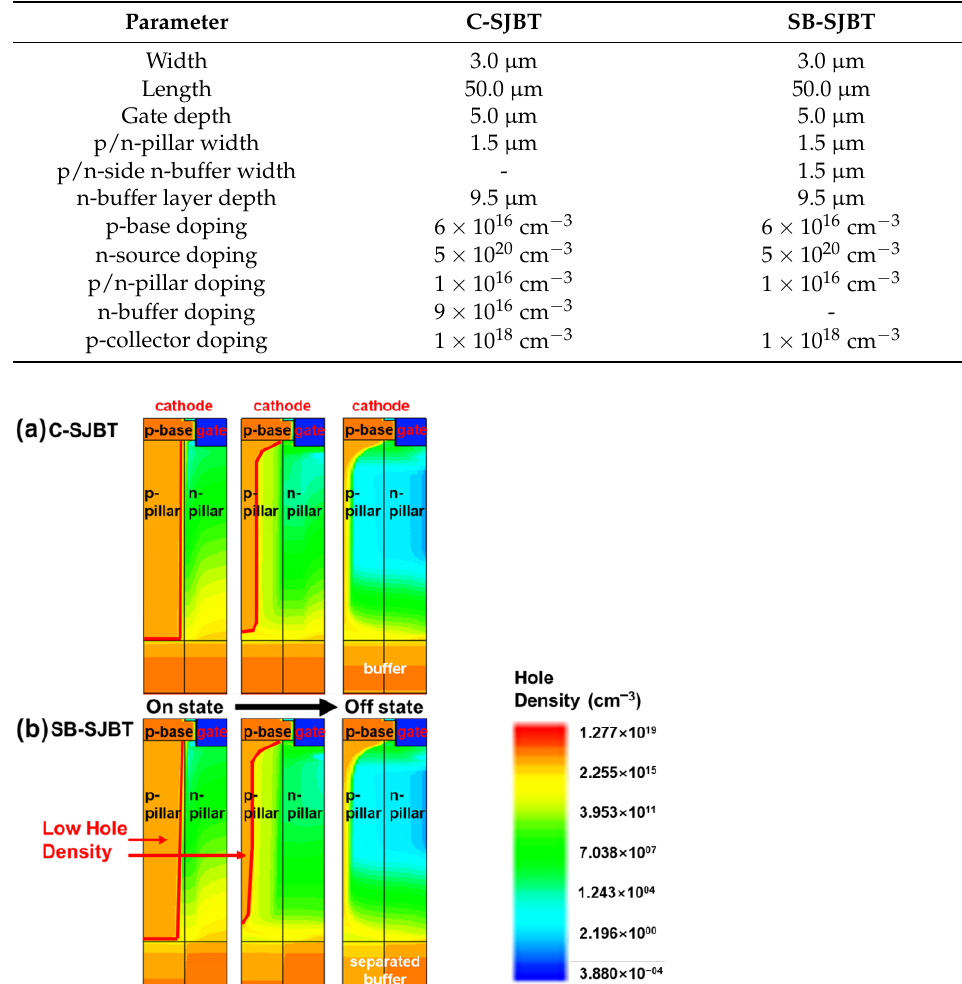
Table 1. Device parameters for the simulation.